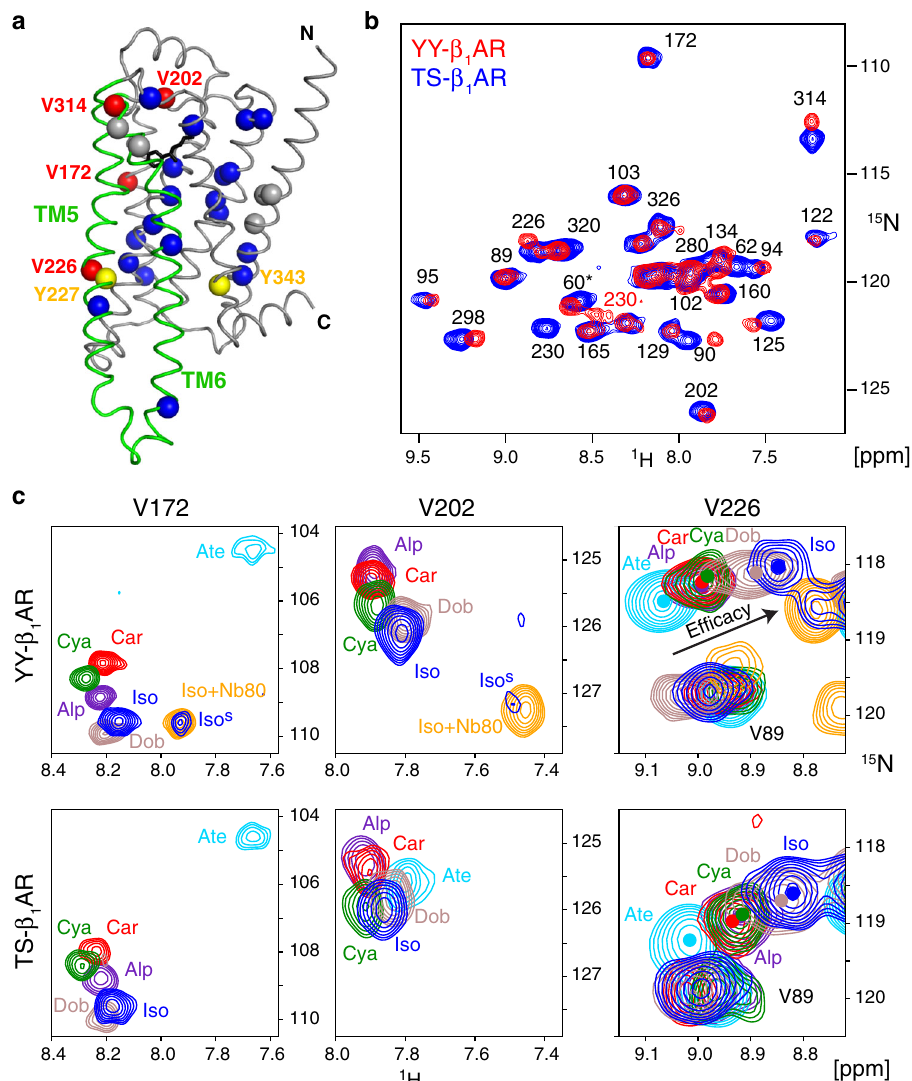
Fig. 1 Ligand-induced 1 H- 15 N chemical shift changes in the YY- β 1 AR and TS- β 1 AR constructs. a Crystal structure of β 1 AR in complex with isoprenaline (2Y03). The protein backbone and isoprenaline are shown in ribbon and stick, respectively, with TM5 and TM6 highlighted in green. Valines are shown as spheres (blue: assigned; gray: not assigned; red: particularly strong chemical shift changes in response to ligands). Tyrosines 227 5.58 and 343 7.53 are depicted as yellow spheres. b 1 H- 15 N TROSY spectra of 15 N-valine-labeled TS- β 1 AR (blue) and YY- β 1 AR (red) in decyl maltoside micelles in the presence of 1 mM isoprenaline. Resonances are marked with assignment information. The assignment of V60 is tentative and marked by an asterisk. c Comparison of V172 4.59 , V202 ECL2 and V226 5.57 1 H- 15 N TROSY resonances of YY- β 1 AR and TS- β 1 AR in orthosteric binary and ternary isoprenaline (cid:129) Nb80 complexes. Resonances of the YY- β 1 AR (cid:129) isoprenaline complex (blue) marked by superscript ‘ s ’ correspond to a second conformation, which coincides with the active conformation in the ternary complex (orange). The arrow indicates the approximate linear correlation between 1 H and 15 N chemical shifts of V226 5.57 in various ligand-bound states and ligand ef fi cacy (see also Supplementary Fig.